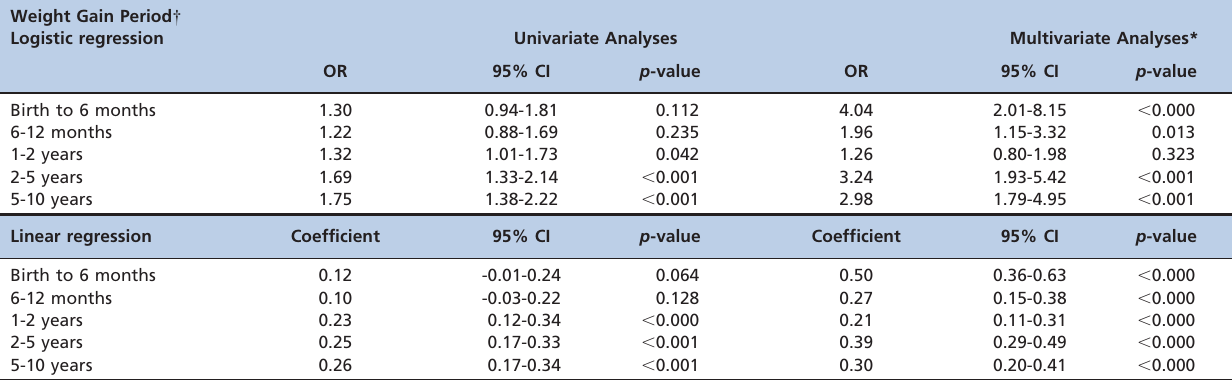
Table 2 - Univariate and multivariate analyses of the association between weight gain in different age periods and overweight/obesity at 10 years of age (n= 147).